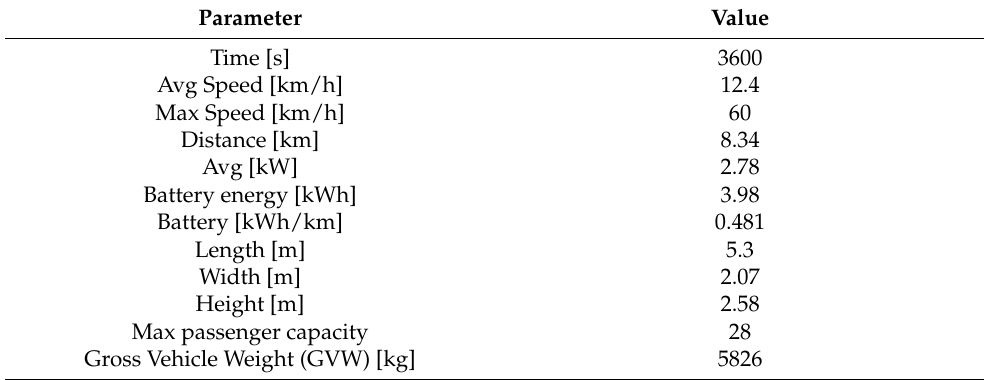
Table 1. Characteristics of the electric bus line 117 in Rome accomplished with a Tecnobus